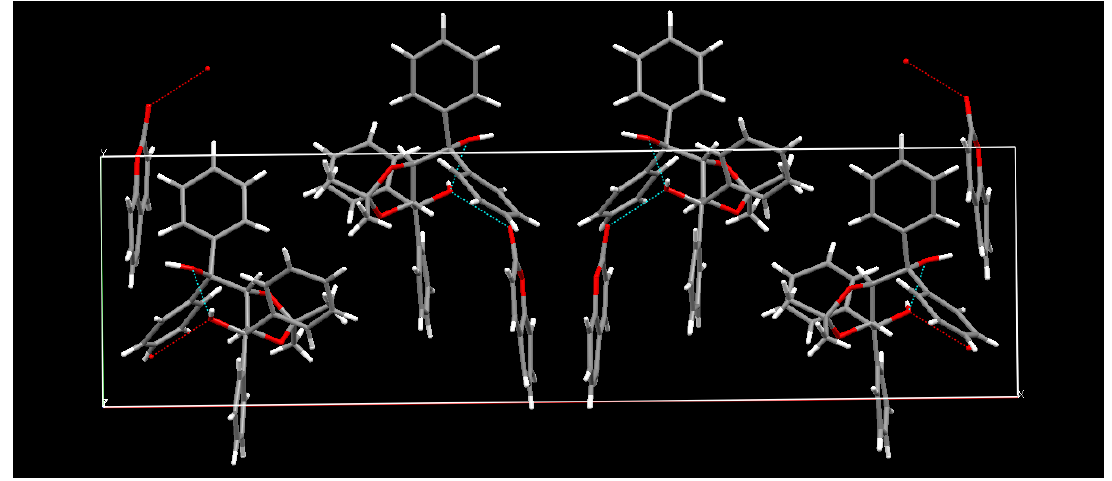
Figure 1. X-ray structure of the 1:1 inclusion complex of (  )- 23 and 1 .